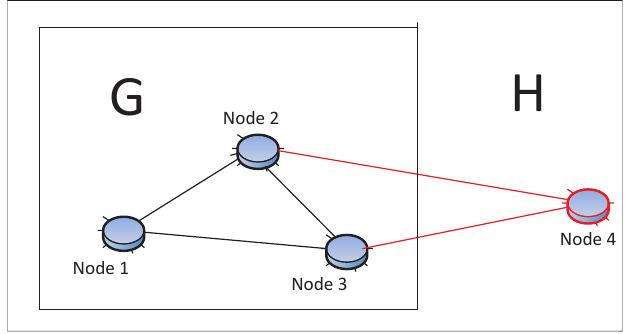
Figure 7. Construct a new 2 − connected network H from the existing 2 − connected network G